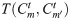
The scatter plot between T(Cmt,Cm′t) and S(Cmt,Cm′t) among all TCs (with at least 100 papers) in 1990s.